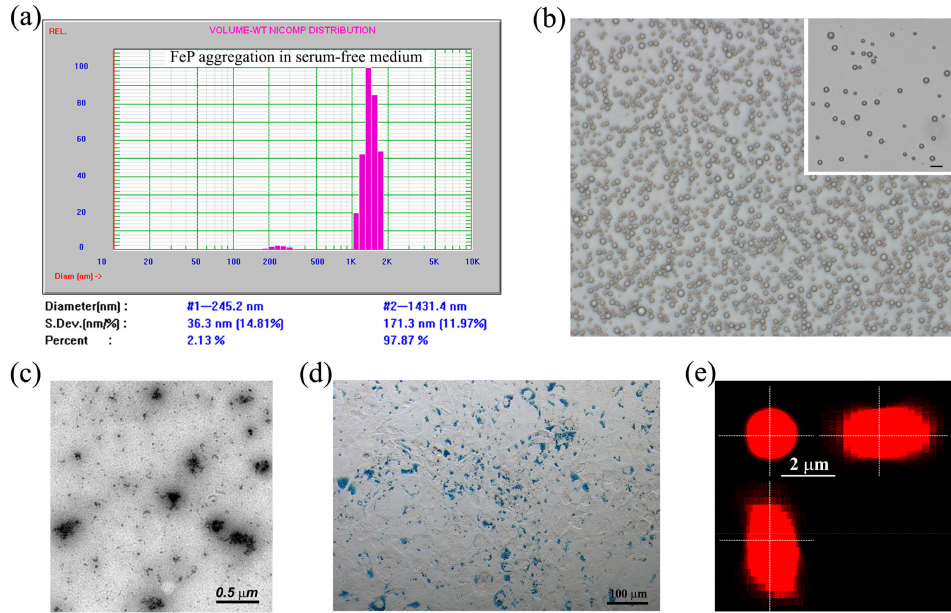
Figure 2. Characterization of Fe-PEI aggregates formed by 24-h incubation in culture medium. ( a ) Nicomp particle size distribution of Fe-PEI aggregates shaped by 24-h of NPs culture in DMEM. The diagrams are representative of at least three experiments performed in duplicate. ( b )Phase-contrast image illustrating the aggregates formed by incubation of Fe-PEI NPs in DMEM in ultra-low attachment conditions. The inset shows a diluted aggregate suspension (scale bar: 5 µ m) illustrating that the aggregates are individual rather than being arranged in strings; ( c ) Electron microscopy micrograph illustrating Fe-PEI aggregates; ( d ) Light microscopy image illustrating the appearance of blue aggregates on MSCs, which are indicative of ferric iron accumulation onto cell surface, after 24-h co-culture with Fe-PEI NPs; ( e ) Orthogonal confocal optical sections of a fluorescently labelled Fe-PEI aggregate produced by incorporation of DiI during assembling demonstrate the uniform distribution of fluorescence within